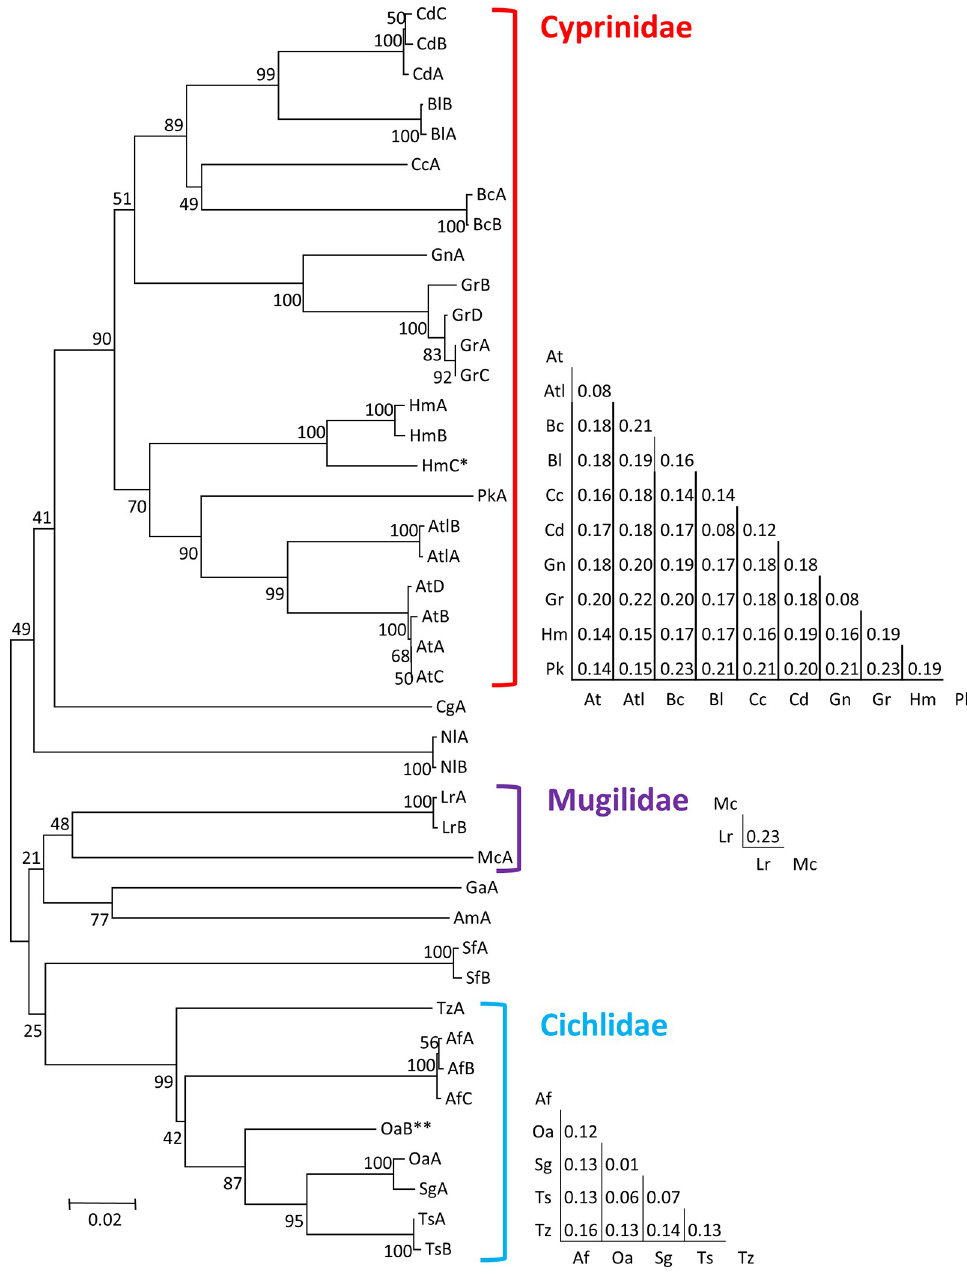
Fig 1. A neighbor-joining unrooted tree of species based on COI haplotypes. Next to branch edges are haplotype acronyms as listed in Table 2. Numbers next to bifurcations denote percent bootstrap support. For some species, more than one haplotype was identified (denoted A, B etc.). For major families, which are represented by multiple species, a mean K2P between species distance matrix is given to the right. ( � )–HmC haplotype derived from specimens suspected as Hypophthalmichthys molitrix x Hypophthalmichthys nobilis hybrids, matches H . nobilis sequences from BOLD. ( �� )— OaB haplotype derived from a specimen suspected as Oreochromis niloticus x Oreochromis aureus hybrid, matches O . niloticus sequences from